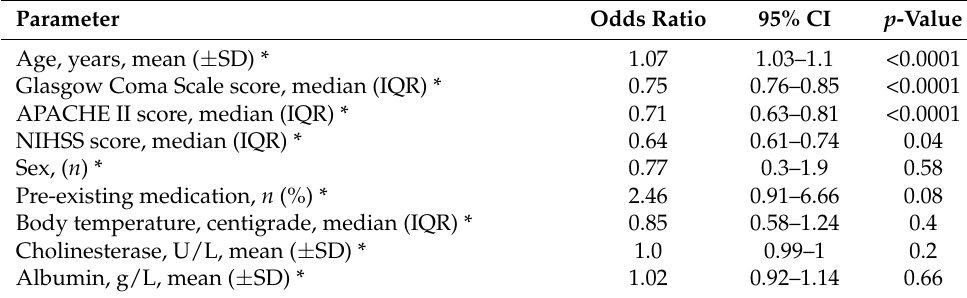
Table 3. Independent predictors of intrahospital mortality after spontaneous